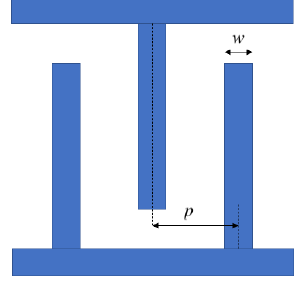
Figure 1. IDT with a metalization ratio of w / p